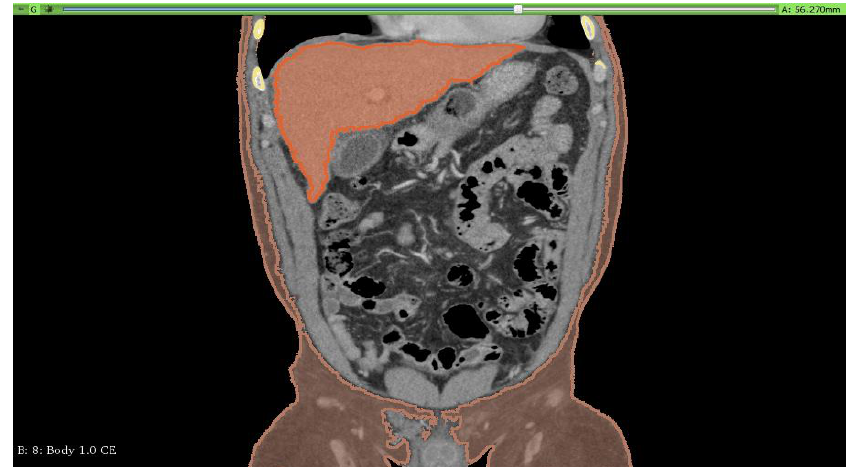
Figure A3: Liver segmentation in 3D slicer